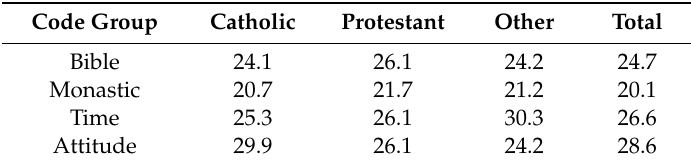
Table 9. Dimensions of reading—personal context—church a ffi liation. Code